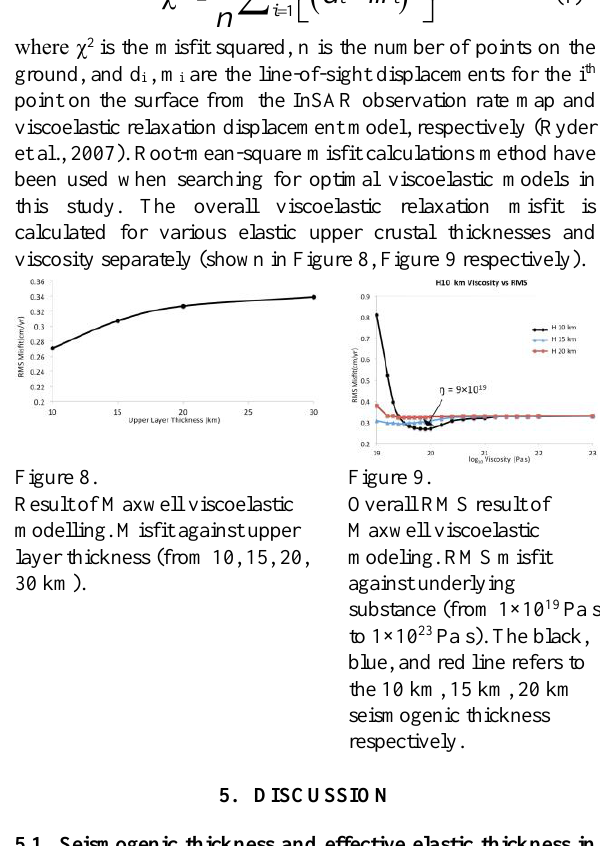
Figure 9. Overall RMS result of Maxwell viscoelastic modeling. RMS misfit against underlying substance (from 1×10 19 Pa s to 1×10 23 Pa s). The black, blue, and red line refers to the 10 km, 15 km, 20 km seismogenic thickness